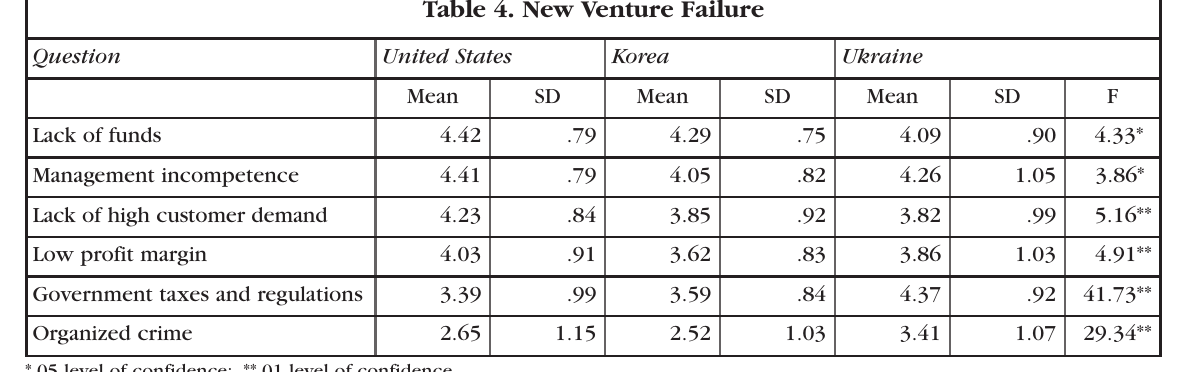
Table 4. New Venture